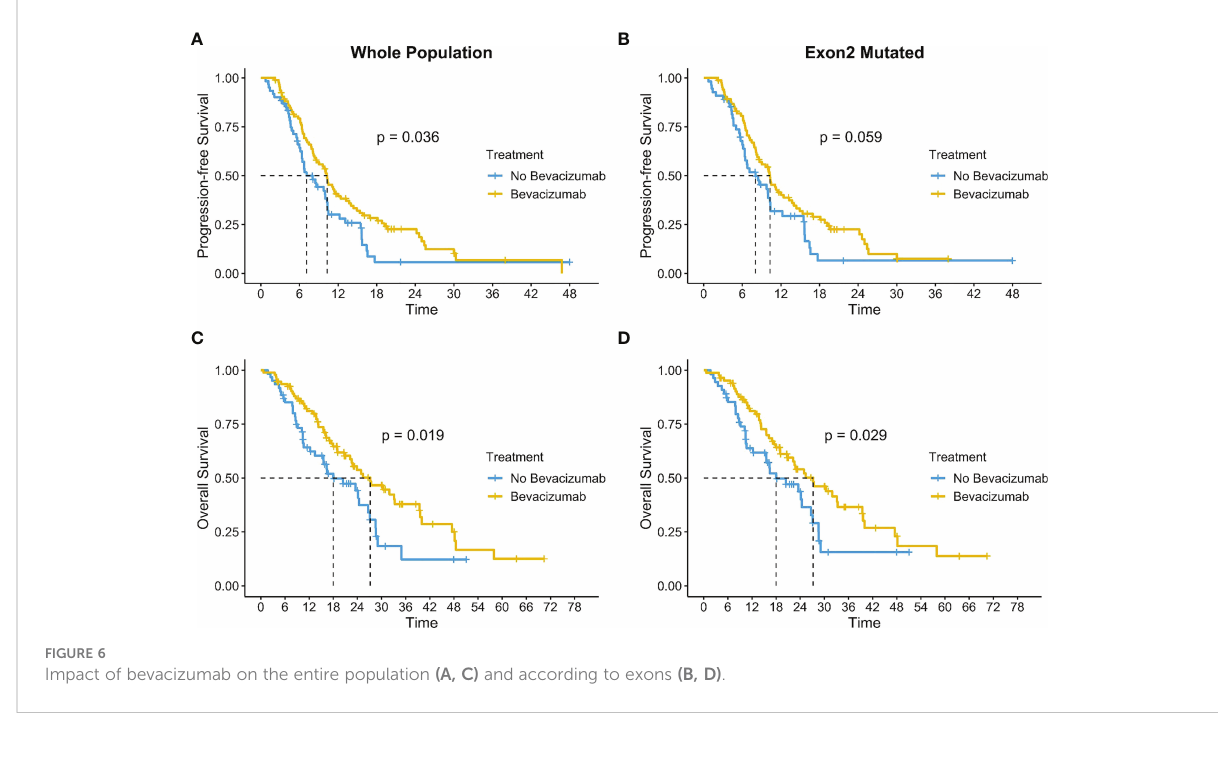
FIGURE 6 Impact of bevacizumab on the entire population (A, C) and according to exons (B, D) .